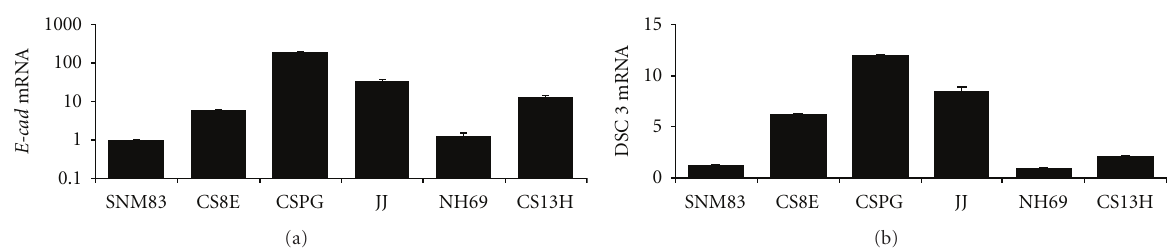
Figure 1: Chondrosarcomas acquire aberrant expression of epithelial-specific genes E -cadherin and desmocollin-3. (a) E-cadherin mRNA expression was measured by real-time PCR. Four of the five chondrosarcoma cell lines (CS8E, CSPG, JJ, and CS13H) showed a significant increase in E-cadherin mRNA expression from approximately 6- to 189-fold increase when compared to the normal SNM83 chondrocyte cell line. SNM83 had minimal expression but was set at 1 on graph as calculated using ΔΔ CT relative quantification method. (b) Desmocollin 3mRNA expression was measured by real-time PCR. Four of the five chondrosarcoma cell lines (CS8E, CSPG, JJ, and CS13H) showed